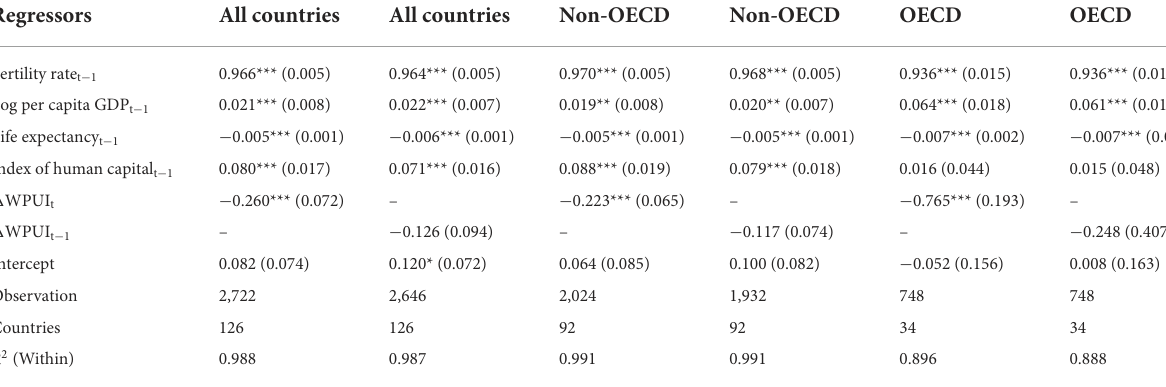
TABLE 5 Persistent fertility rates: fixed-effects estimations for Model II (1996–2019).